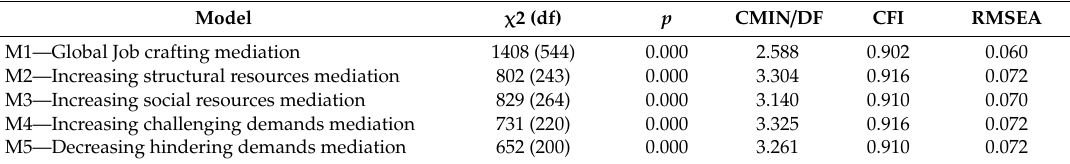
Table 3. Fit indices of the alternative